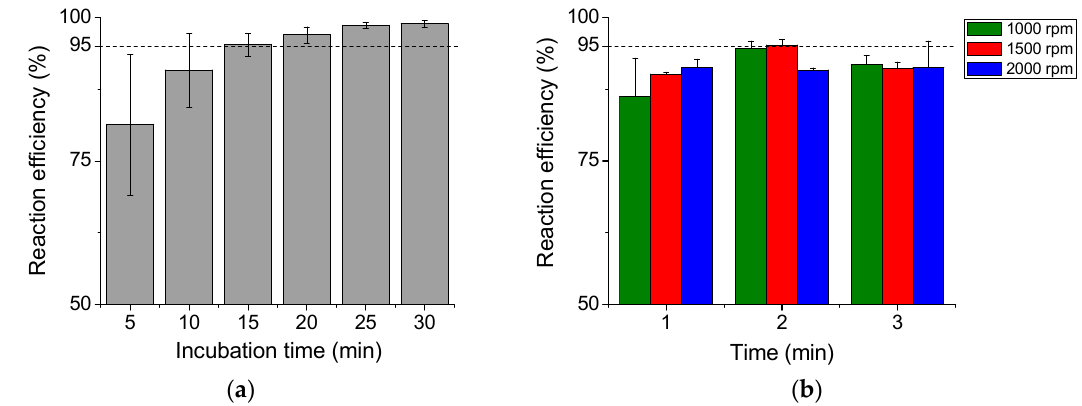
Figure 5. ( a ) Reaction e ffi ciency measured at the di ff usion-based reaction process for di ff erent incubation times from 5 to 30 min with an interval of 5 min. ( b ) Reaction e ffi ciency achieved by bidirectional rotation mixing at di ff erent motor rotation speeds (1000, 1500, and 2000 rpm) and durations (1, 2, and 3